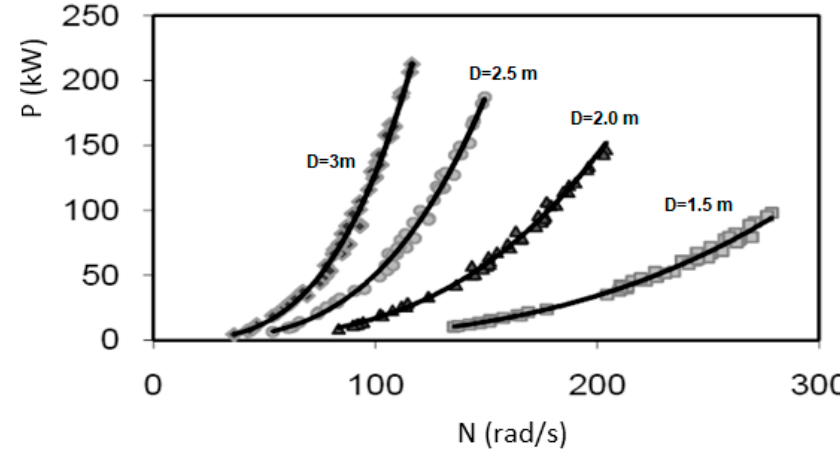
Figure 10. Average Wells turbine shaft power vs. optimum rotational speed (D in m).